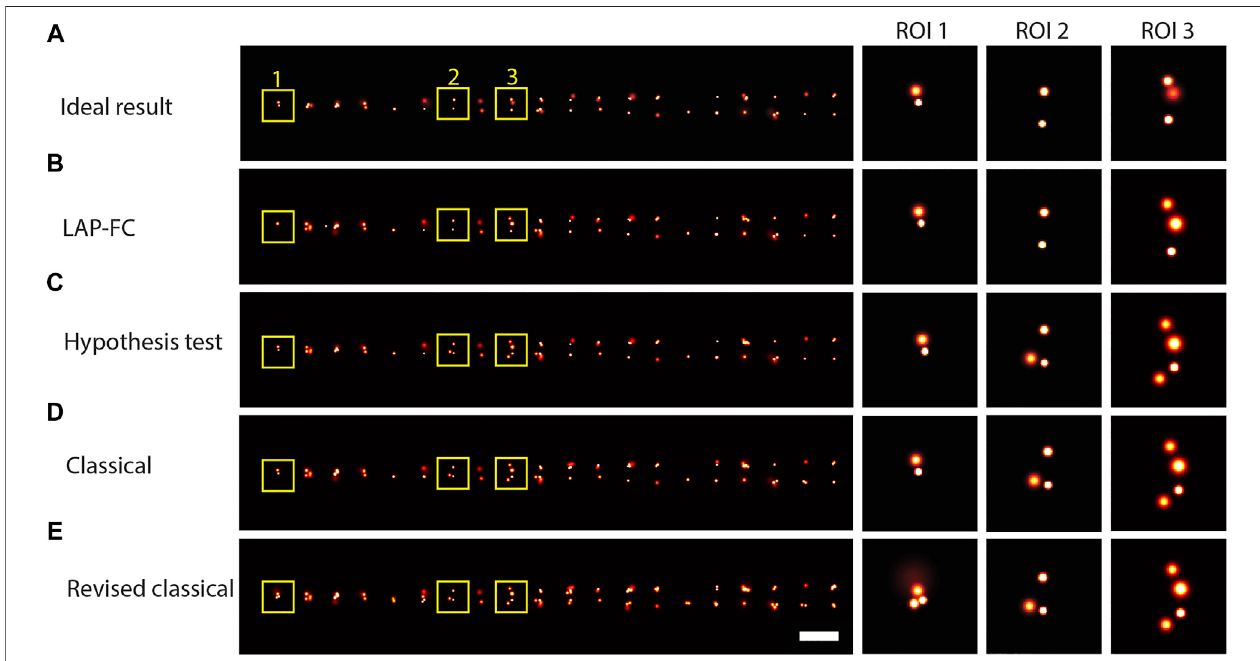
FIGURE 3 | Gaussian reconstruction images for frame-connection results on simulated dimer emitters with spatial separations ranging from 0.1-1 pixel, k on (cid:2) 0.005/frame, k off (cid:2) 0.5/frame, k bleach (cid:2) 0.2/frame, p miss (cid:2) 0.01, photon emission rate of 1,000 photons/frame, and 10,000 total frames. (A) “ Ideal ” frame-connection solution,scalebar (cid:2) 2pixels. (B) – (E) Resultsforthethreesub-ROIsmarkedwithyellowsquaresin (A) using (B) LAP-FCwithamaximumpre-clusteringframegapof fi ve frames and a maximum separation of 5 times the localization error; (C) the hypothesis test algorithm with a maximum frame gap of fi ve frames, a maximum separationof1pixel,andalevel-of-signi fi canceof0.05; (D) theclassicalalgorithmwithamaximumframegapof1frameandamaximumseparationof0.2pixels;and (E) the revised classical algorithm with a maximum frame gap of fi ve frames and a maximum separation of 2 times the localization error. Scale bar (cid:2) 2 pixels.